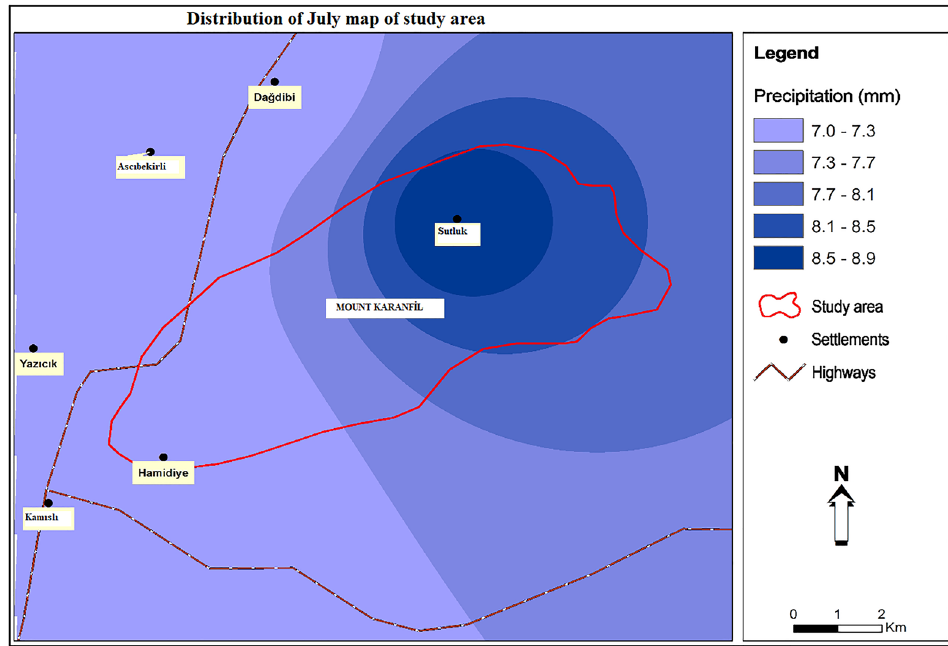
Fig. 17 Distribution of July map of study area (Çetin 2020)